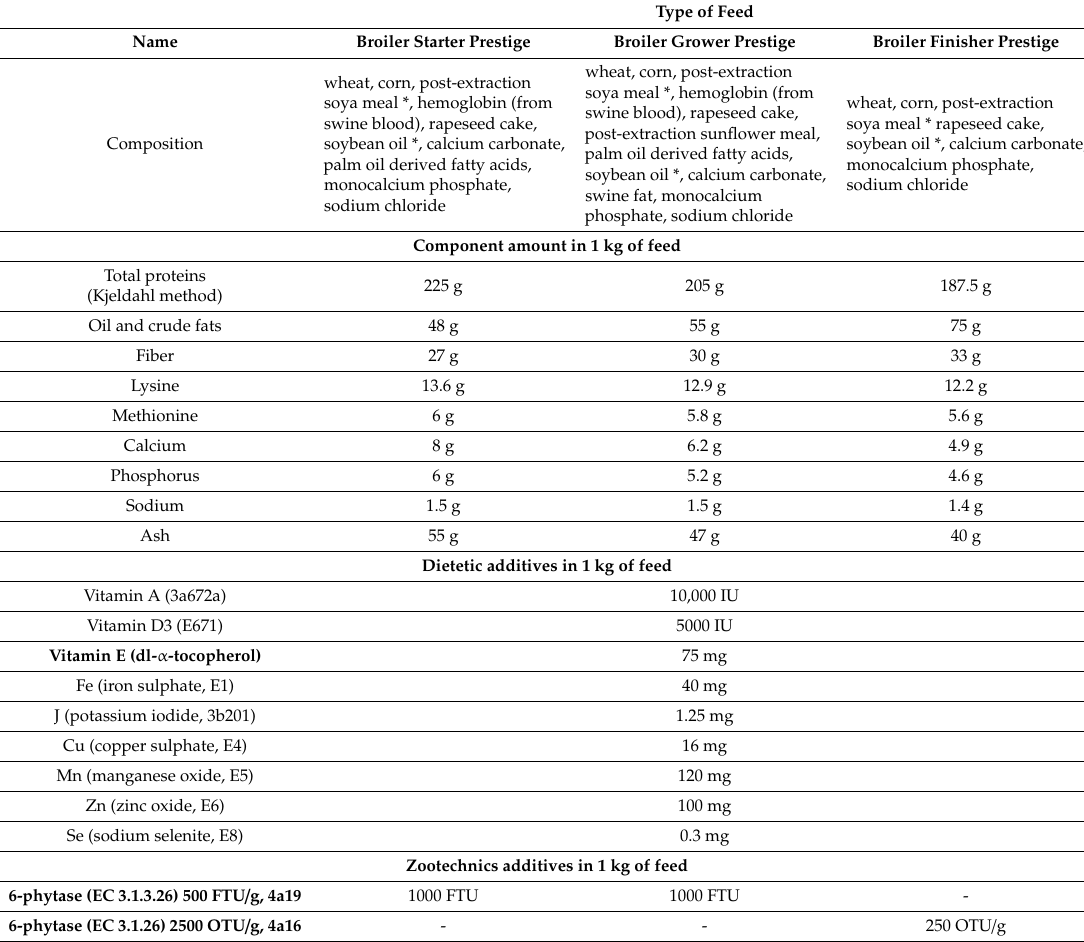
Table 2. The composition of the complete dietetic commercial mixtures of feed used in the